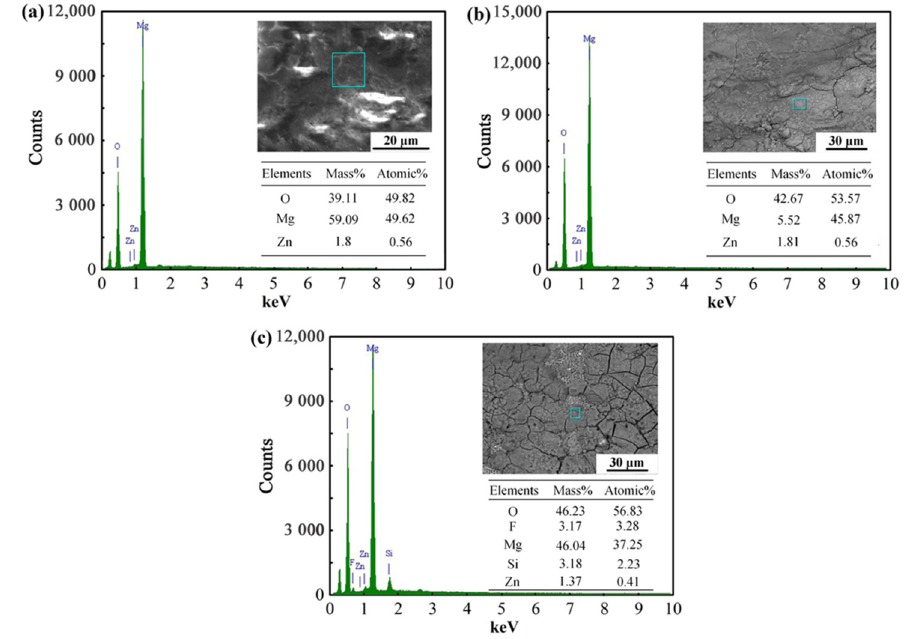
Figure 16. Representation EDS analyses of specimens in 3.5 wt.% NaCl solution under 80 MPa, ( a ) ZK60E, ( b )ZK60EF-300, and ( c ) ZK60EF-300 with MAO coating.